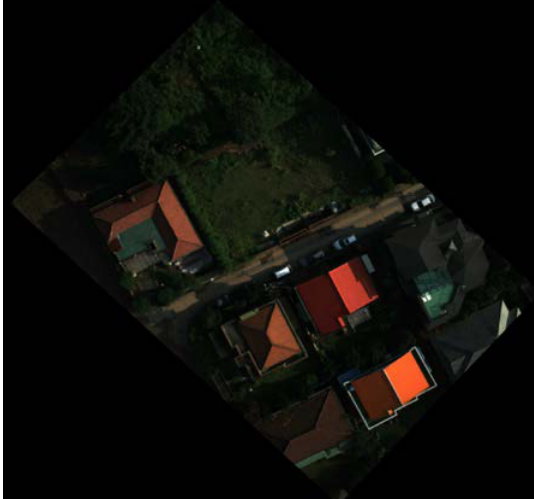
Figure 7. Ortho-image